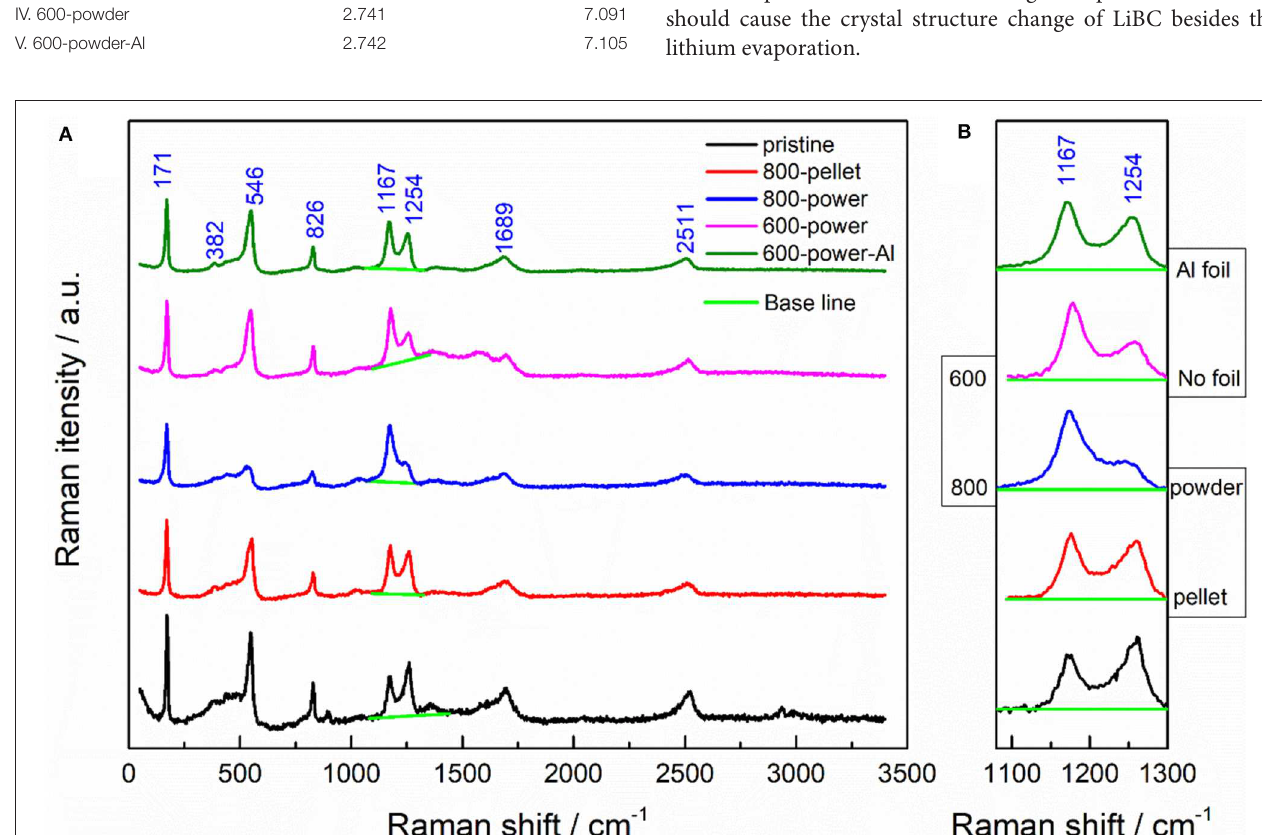
FIGURE 4 | (A) The Raman spectra of five LiBC samples. (B) The enlarged views for two Raman peaks after the baseline subtraction.